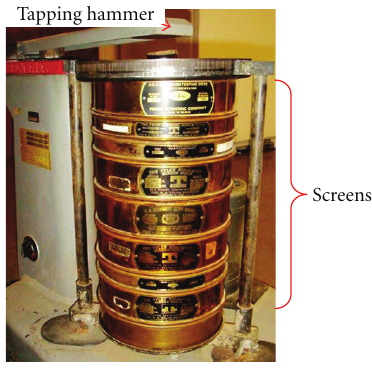
Figure 9: W.S. Tyler screen